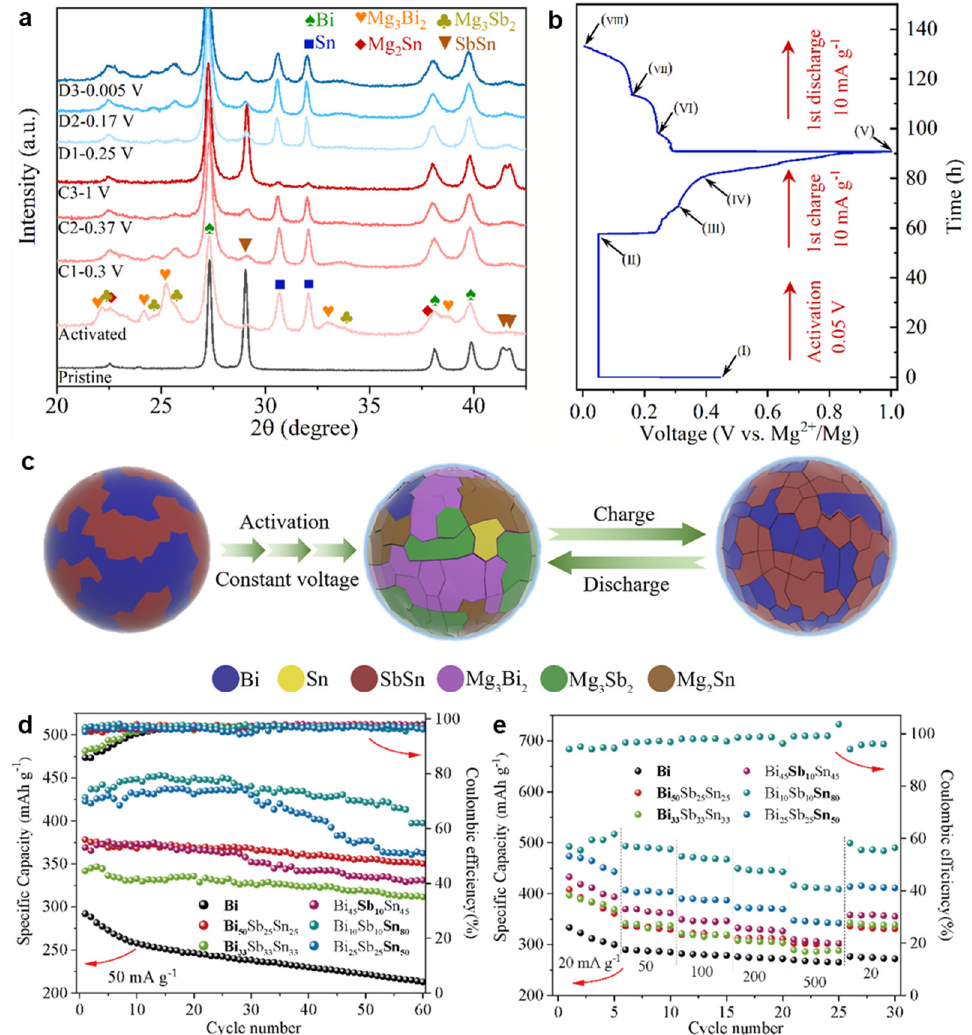
Figure 14. ( a ) The ex situ XRD patterns of the Bi 33 Sb 33 Sn 33 electrode at the varied states in cycling. ( b ) The discharge/charge curve of Bi 33 Sb 33 Sn 33 electrode at 10 mA g − 1 corresponding to ( a ). ( c ) Schematic illustration of the electrochemical reaction mechanism of Bi 33 Sb 33 Sn 33 particles during the discharge/charge process. ( d ) Cycling stability and ( e ) rate performance of the Bi and Bi-Sb-Sn anodes. Reproduced with permission [52]. Copyright 2022, Elsevier B.V.